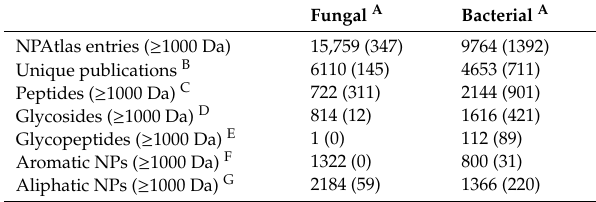
Table 2. NPAtlas entries and unique publications number according to the origin and molecular weight. Fungal